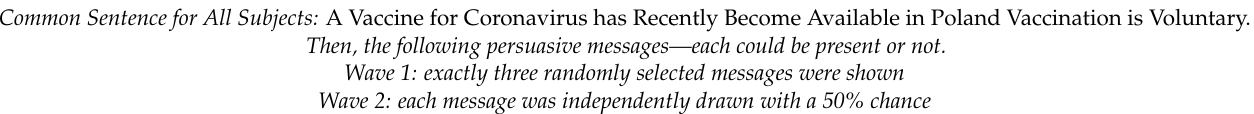
Table 1. Messages employed in the